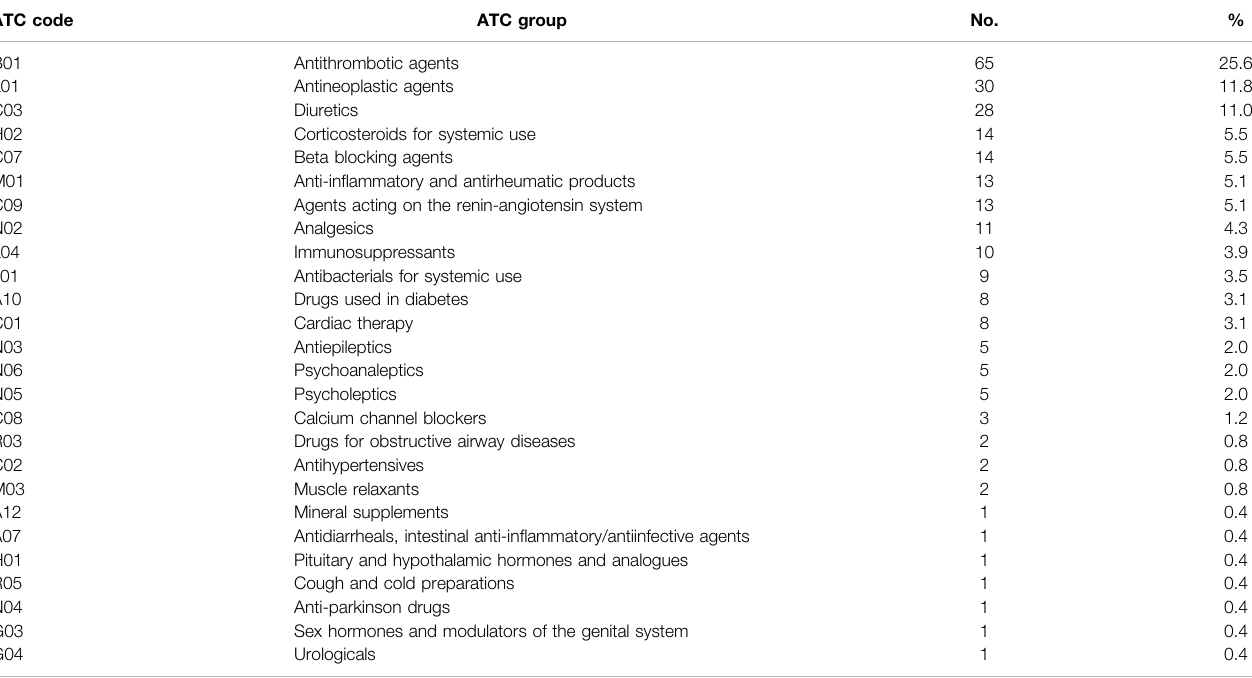
TABLE 6 | ATC classi fi cation of medication classes involved in DRAs related to treatment safety (N = 254). ATC